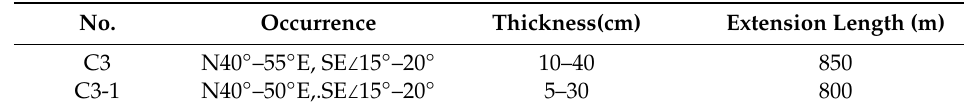
Table 2. Characteristics of the faults.